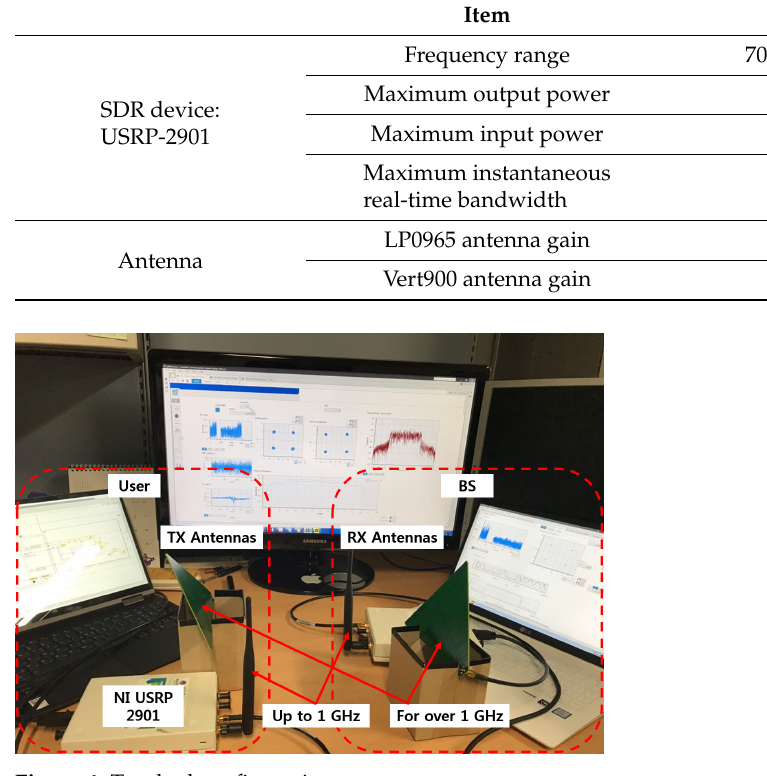
Figure 4. Test-bed configuration.